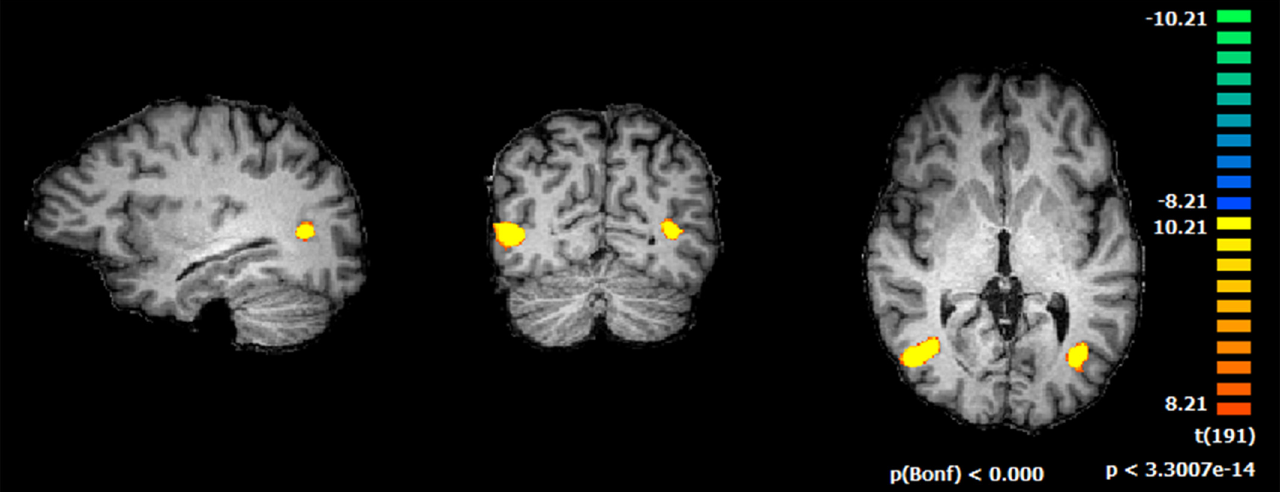
Fig 2. Example of hMT+/V5 identification using the defined localizer. GLM conjunction analysis (using the stringent criterion that all particular motion vs static BOLD signal contrasts had to be significant for a voxel to be considered positive) shows the resulting ROI: hMT+/V5. Regions are shown at the same statistical threshold level ( P < 0.0001, Bonferroni corrected).